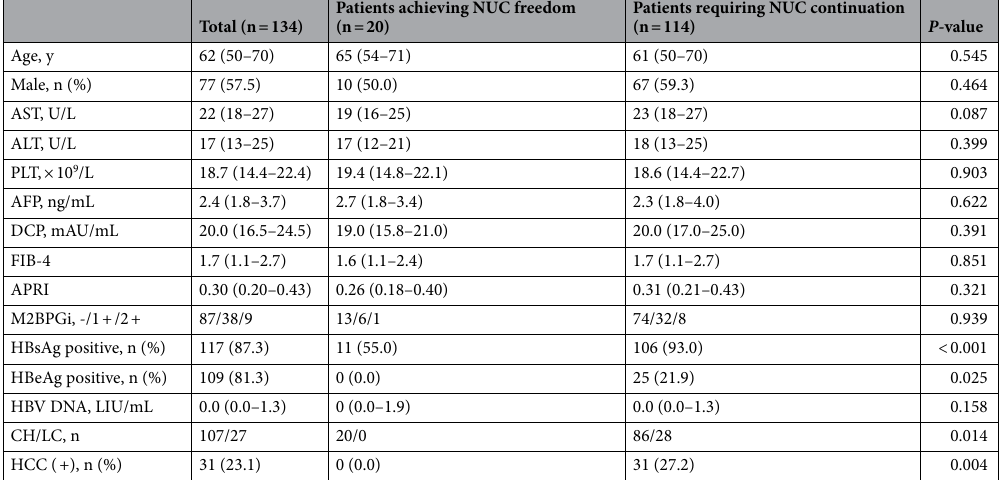
Table 5. Demographic and clinical characteristics of patients receiving NUC treatment. NUC nucleot(s) ide analogue, AST aspartate aminotransferase, ALT alanine aminotransferase, PLT platelet count, AFP α-fetoprotein, DCP des-γ-carboxy prothrombin, FIB-4 fibrosis index-4, APRI aspartate aminotransferase to platelet ratio index, M2BPGi MAC-2 binding protein glycosylation isomer, HBV hepatitis B virus, CH chronic hepatitis, LC liver cirrhosis, HCC hepatocellular